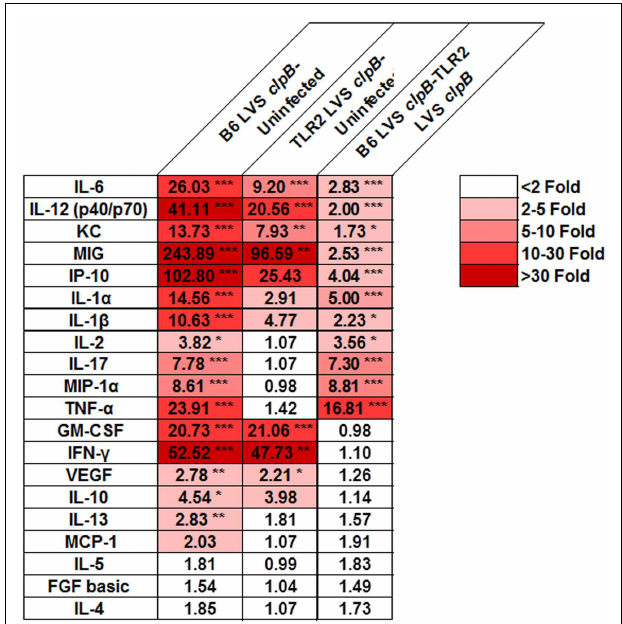
FIGURE 5 |TLR2 signaling is required for maximal cytokine and chemokine production in the lung after LVS clpB inoculation . B6 or TLR2 KO mice were intranasally inoculated with 5 × 10 4 CFU LVS clpB or were left naive.Three days post-inoculation, mice were sacrificed and BALF was collected, and cytokine and chemokine concentrations were determined using a Luminex-based assay. For each pair of groups, a fold-changed was determined based on the average cytokine or chemokine concentrations. Data are combined from two independent experiments. n = 7–12 mice/group. Statistical significance was determined using ANOVA withTukey’s post-test on the absolute concentration of each